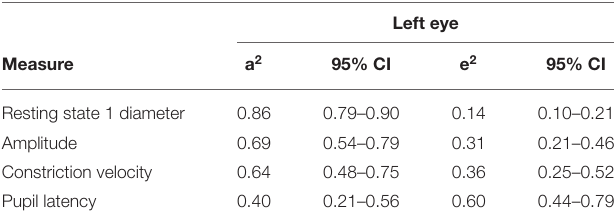
TABLE 5 | Standardised parameter estimates for the best fitting models for the left